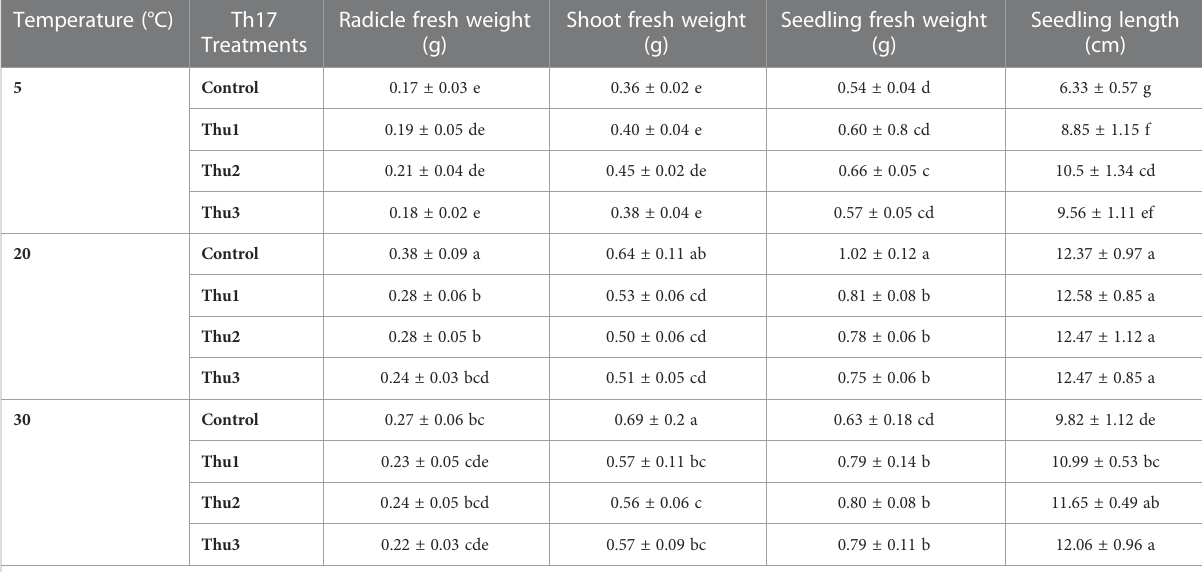
TABLE 1 Effects of temperature and Th17 concentrations on radicle, shoot and seedling fresh weight and length. Temperature